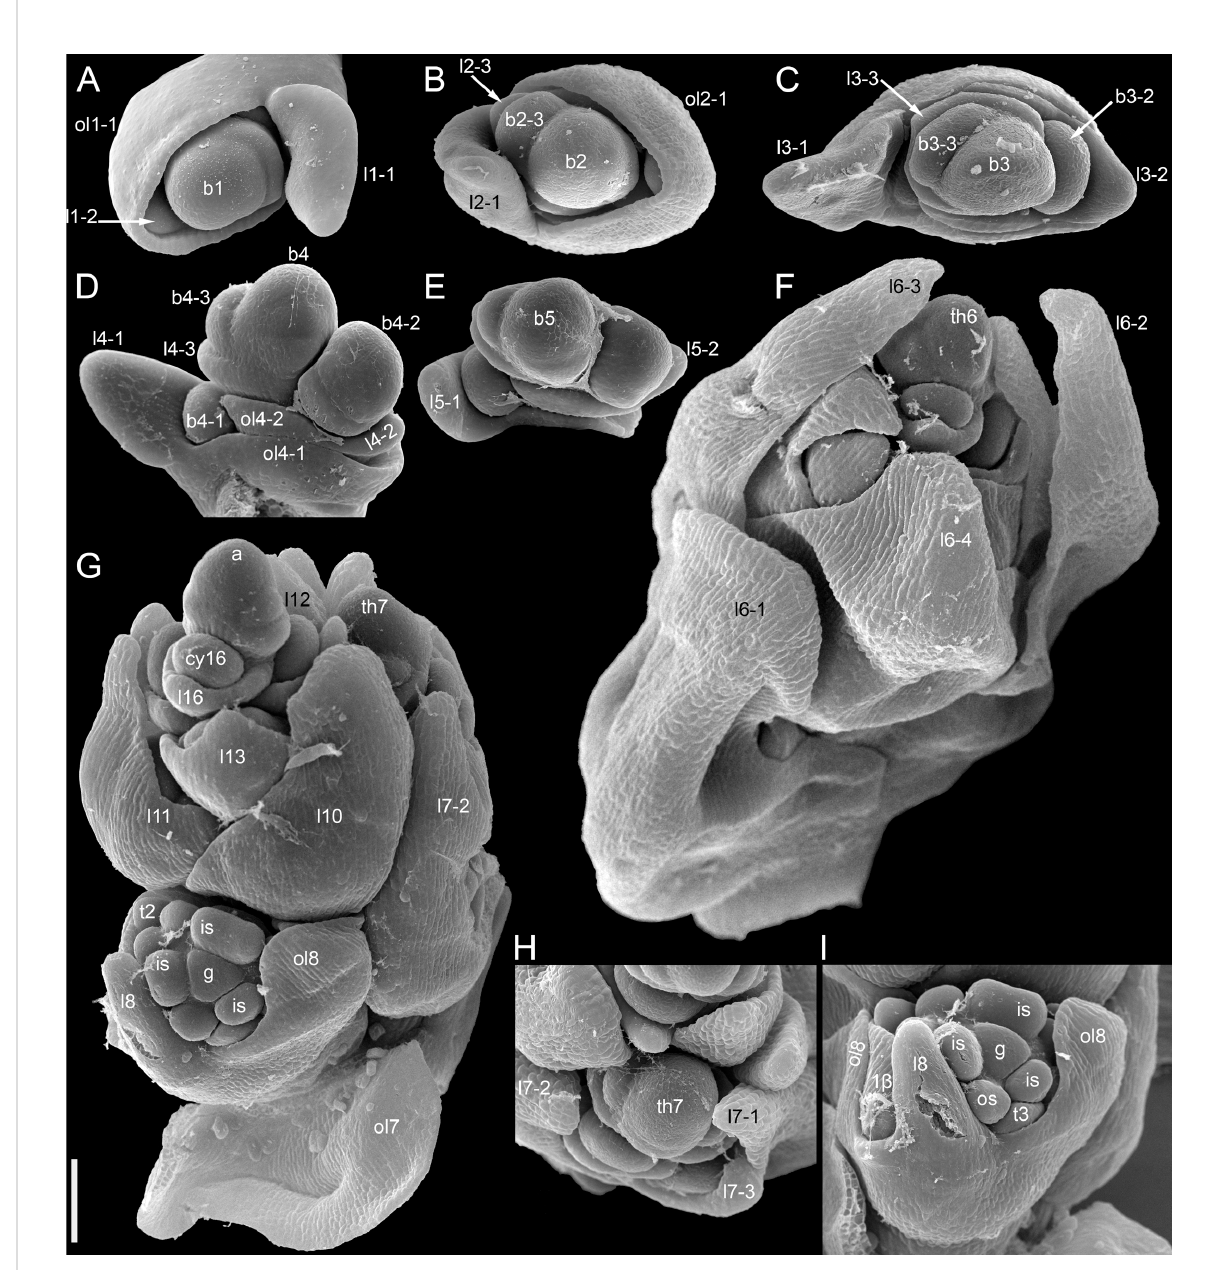
FIGURE 12 Dissected young plant of Fagopyrum esculentum subsp. esculentum cv. Dozhdik with determinate growth pattern (SEM). See Figure 5, for its diagram. The plate shows the terminal thyrse and branches developing in axils of all foliage leaves of the main axis except cotyledons. (A) Branch in the axil of the fi rst leaf. Similar branches were found in axils of the cotyledons. (B – E) Branches in axils of the second, third, fourth and fi fth leaf, respectively. (F) Lateral thyrse in axil of the leaf 6. (G) The terminal thyrse and a lateral thyrse in axil of the leaf 7 (right). (H) Apex of the thyrse in the axil of the leaf 7. (I) The fi rst cyme of the terminal thyrse subtended by leaf 8 of the main axis. The leaf 8 has a reduced lamina. The fi rst fl ower of the cyme is visible. It is at developmental stage 7 (as in Figures 3G – I). 1 b , b -prophyll of the fi rst fl ower of a cyme (see Figure 3); a, apex of the main axis; b, branch apex (where can be precisely identi fi ed, these branches are paracladia); cy, cyme; g, gynoecium; is, inner whorl stamens; l, leaf (foliage leaf or cyme-subtending bract); ol, ocrea of leaf; os, outer whorl stamens; th, thyrse apex; t2, t3, tepals 2 and 3 (see Figure 3). Leaves of the main axis are numbered (cotyledons not counted). Leaves of lateral axes have double numbers, the fi rst one being the number of the main axis leaf subtending the branch. Numbers of all axillary structures are those of their subtending leaves. Scale bar (common to all images) = 100